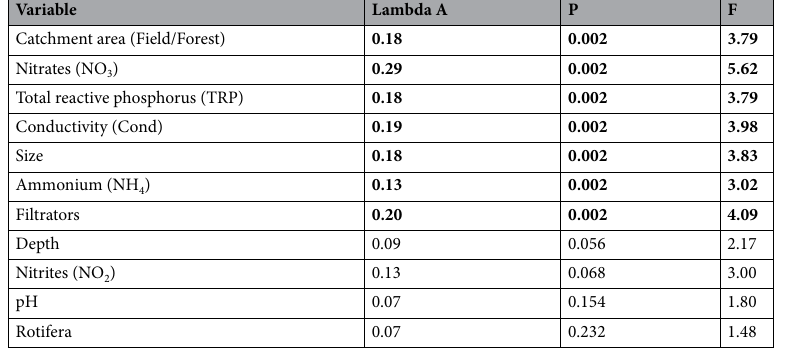
Table 2. Results of CCA on relation between abundance of chlorophyte species and diversity and physical– chemical and biological parameters among field and forest ponds. Values of p and F are calculated using Monte Carlo permutation test with 999 permutations. The overall percentage of explained variance was 25.95%. Bold = variables significantly adding to the model at p < 0.05 level (see Fig. 1).